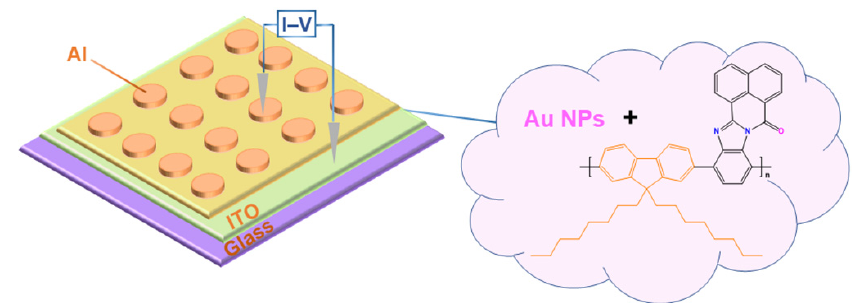
Figure 2. Structure diagram of the memory device.